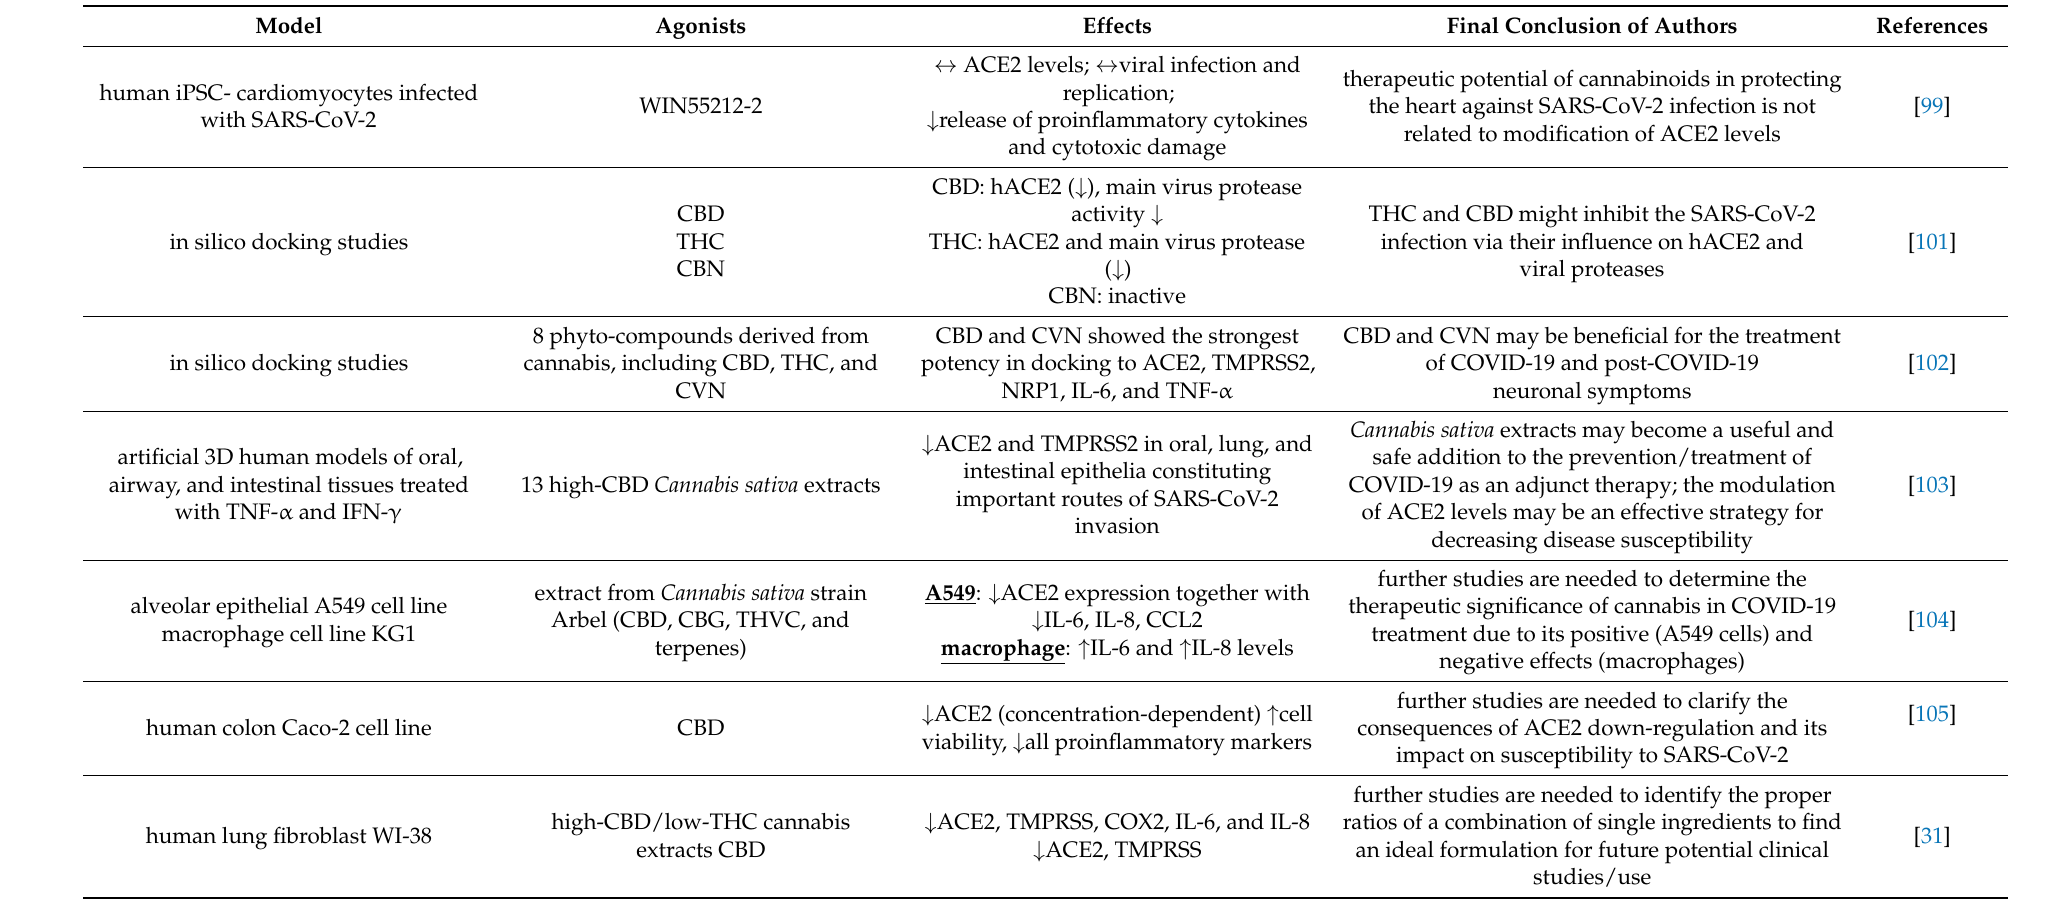
Table 4. Influence of cannabinoids on ACE2 activity and other relevant effects in the fight against